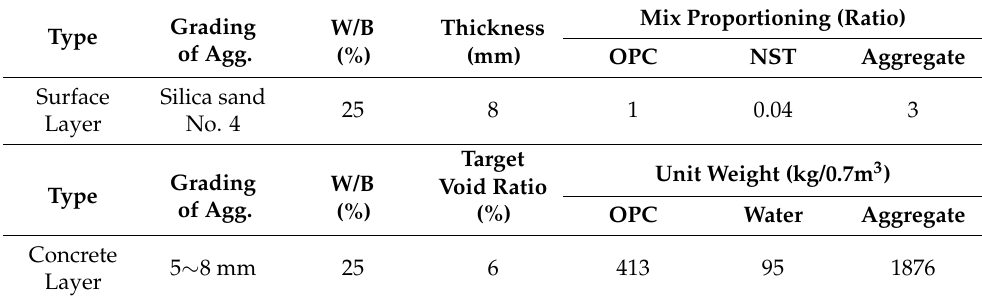
Table 5. Mix proportion of concrete